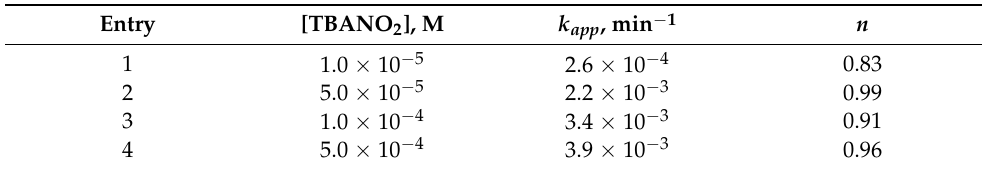
Table 2. Kinetic parameters for the aggregation of CoTPP-N (5.0 × 10 − 6 M) in the presence of NO 2 −